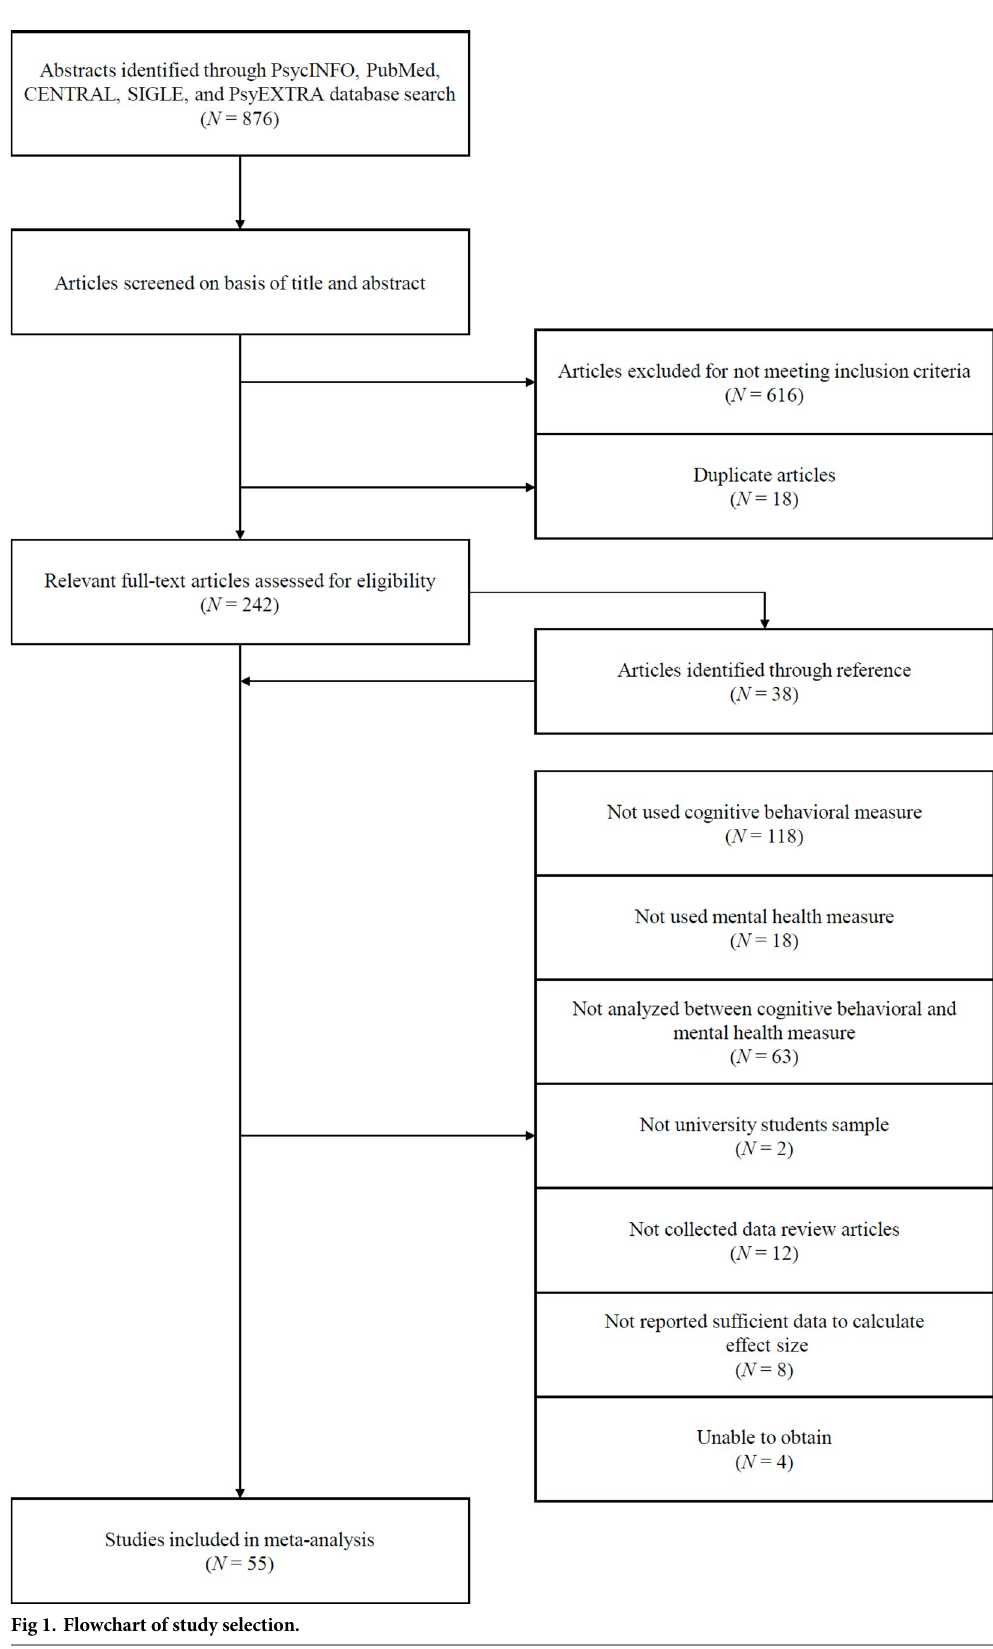
Fig 1. Flowchart of study